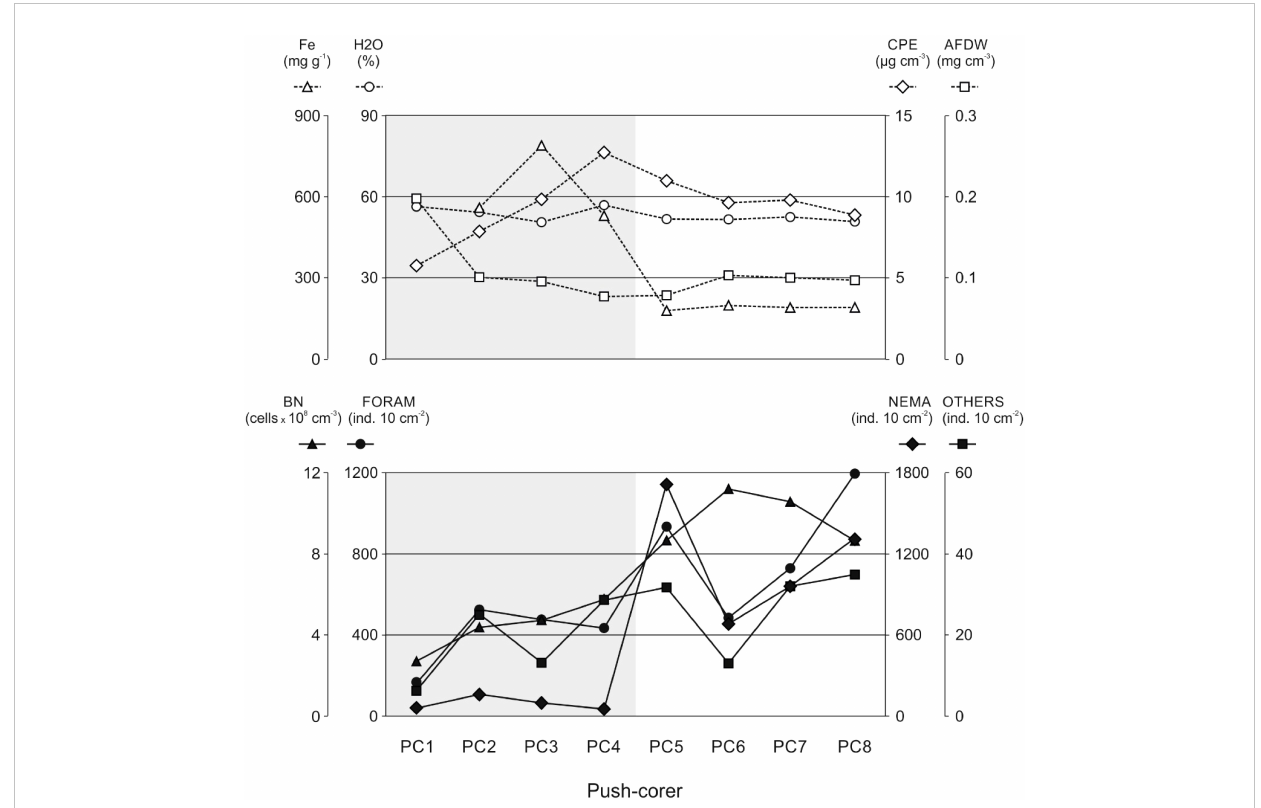
FIGURE 2 Sediment characteristics (upper panel) and densities of the small benthic biota (lower panel) along the push-corer transect. Fe: iron concentrations (no data for PC1), H2O: water contents (porosity), AFDW: organic matter contents, CPE: chloroplastic pigment equivalent concentrations, BN: bacterial densities, FORAM: Foraminifera, NEMA: Nematoda, and OTHERS: all other metazoan meiofauna. Grey shading: visually iron-impacted